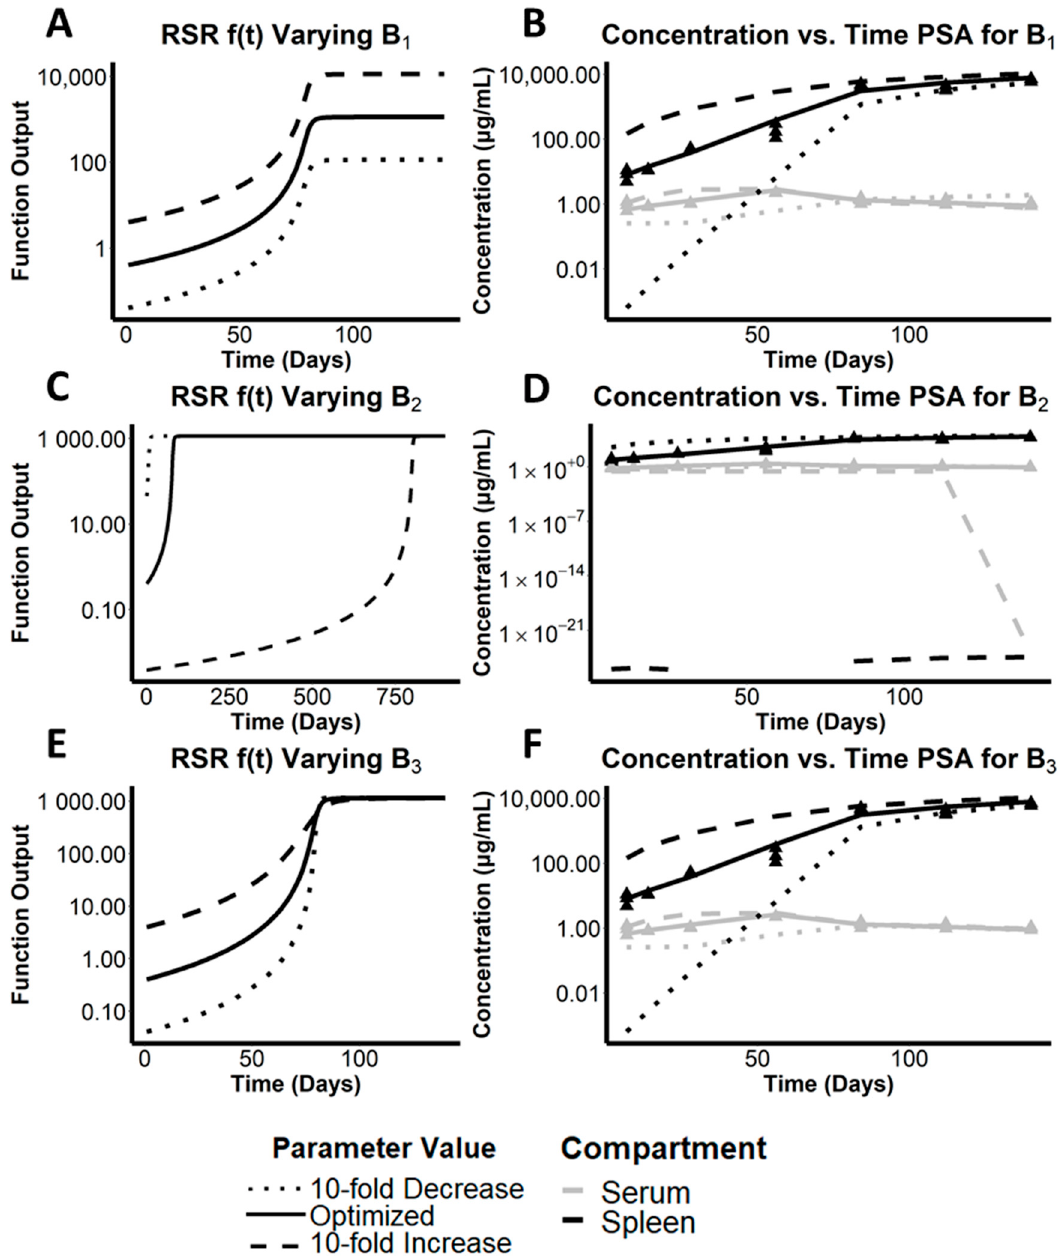
Figure 2. Mathematical analysis of parameters governing the phase transition. Plots ( A , C , E ) demon- strate the parameterization of the RSR f(t) function by increasing/decreasing each parameter from the optimal values by an order of magnitude, where the solid line is the optimized value, the dotted line is a 10-fold decrease, and the dashed line is a 10-fold increase; ( A ) B 1 with a 10-fold increase and decrease, ( C ) B 2 with a 10-fold increase and decrease, and ( E ) B 3 with a 10-fold increase and decrease. Plots ( B , D , F ) show the predicted concentration/time changes with respect to a 10-fold increase (dashed lines) and decrease (dotted lines) of parameter: ( B ) B 1 , ( D ) B 2 , and ( F ) B 3 compared to the predicted concentration over time for the optimized parameters. The triangle points represent the observed data points in both the serum (grey) and spleen (black).